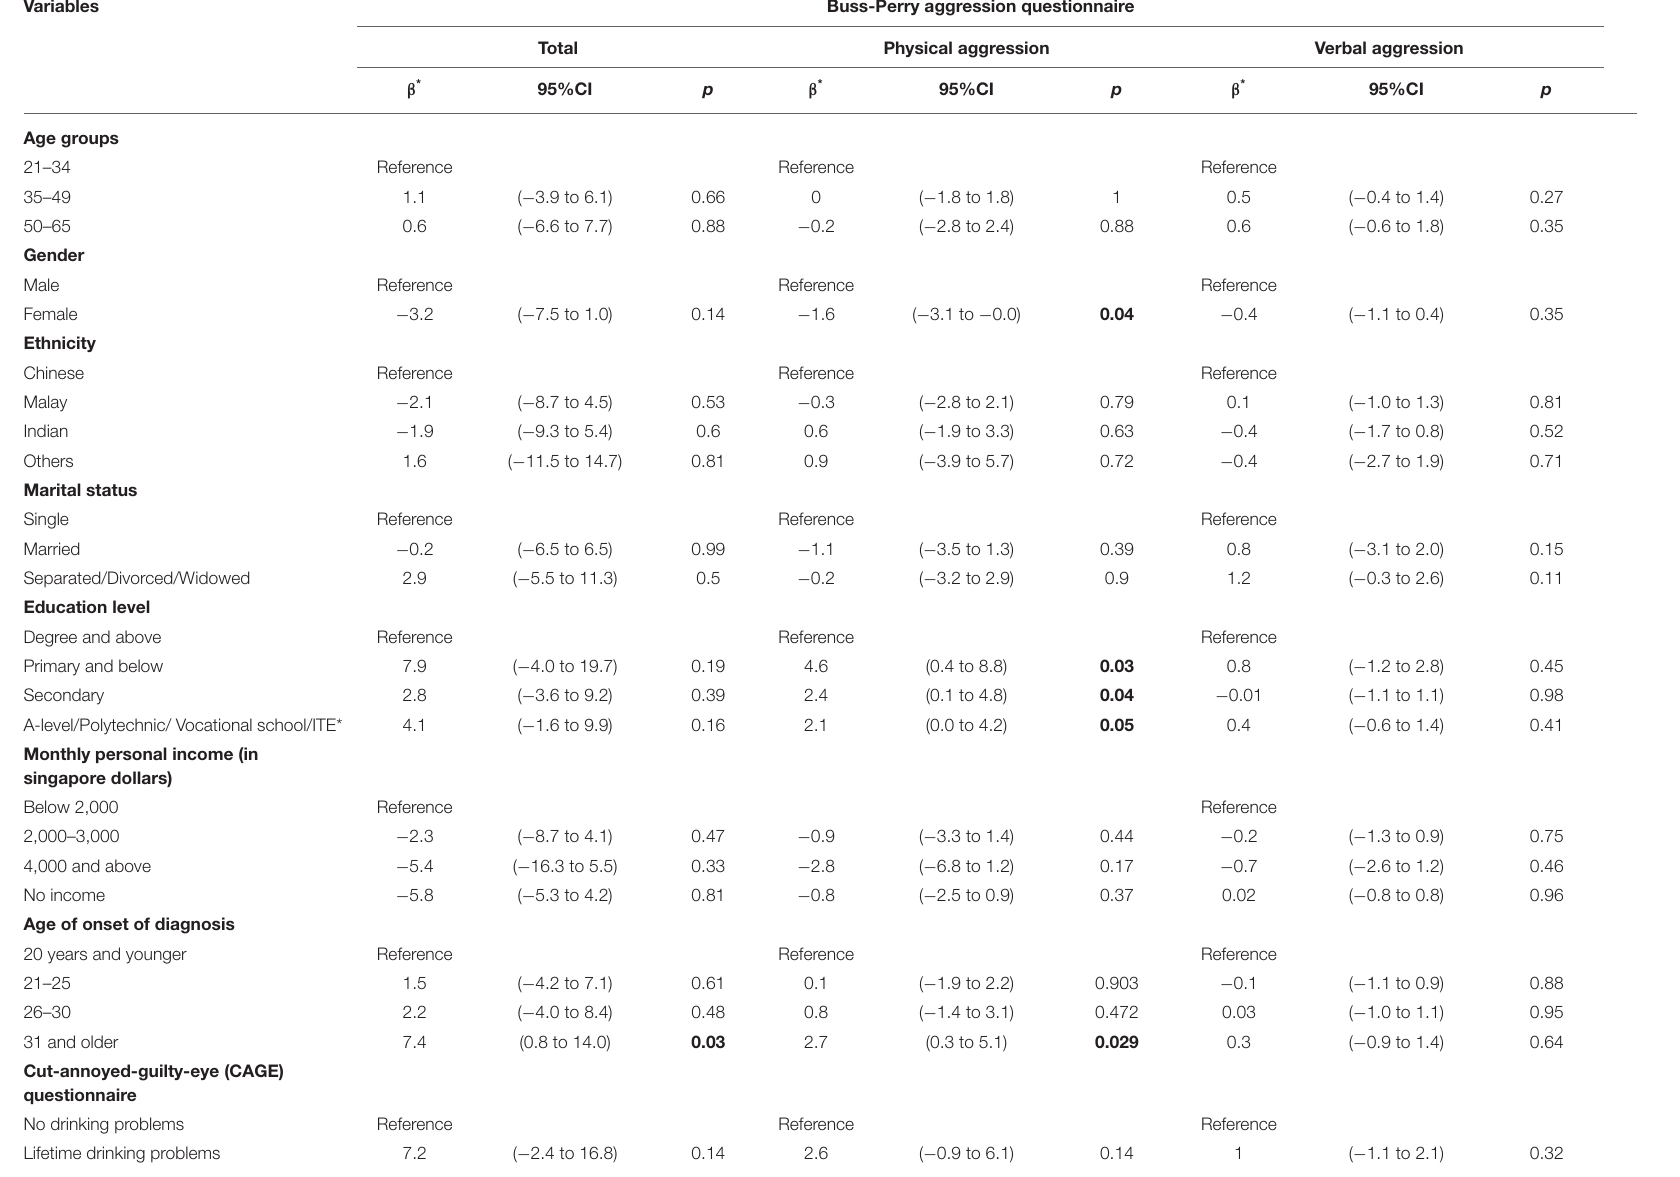
TABLE 3 | Socio-demographic and clinical correlates of Buss-Perry Aggression Questionnaire (BPAQ).